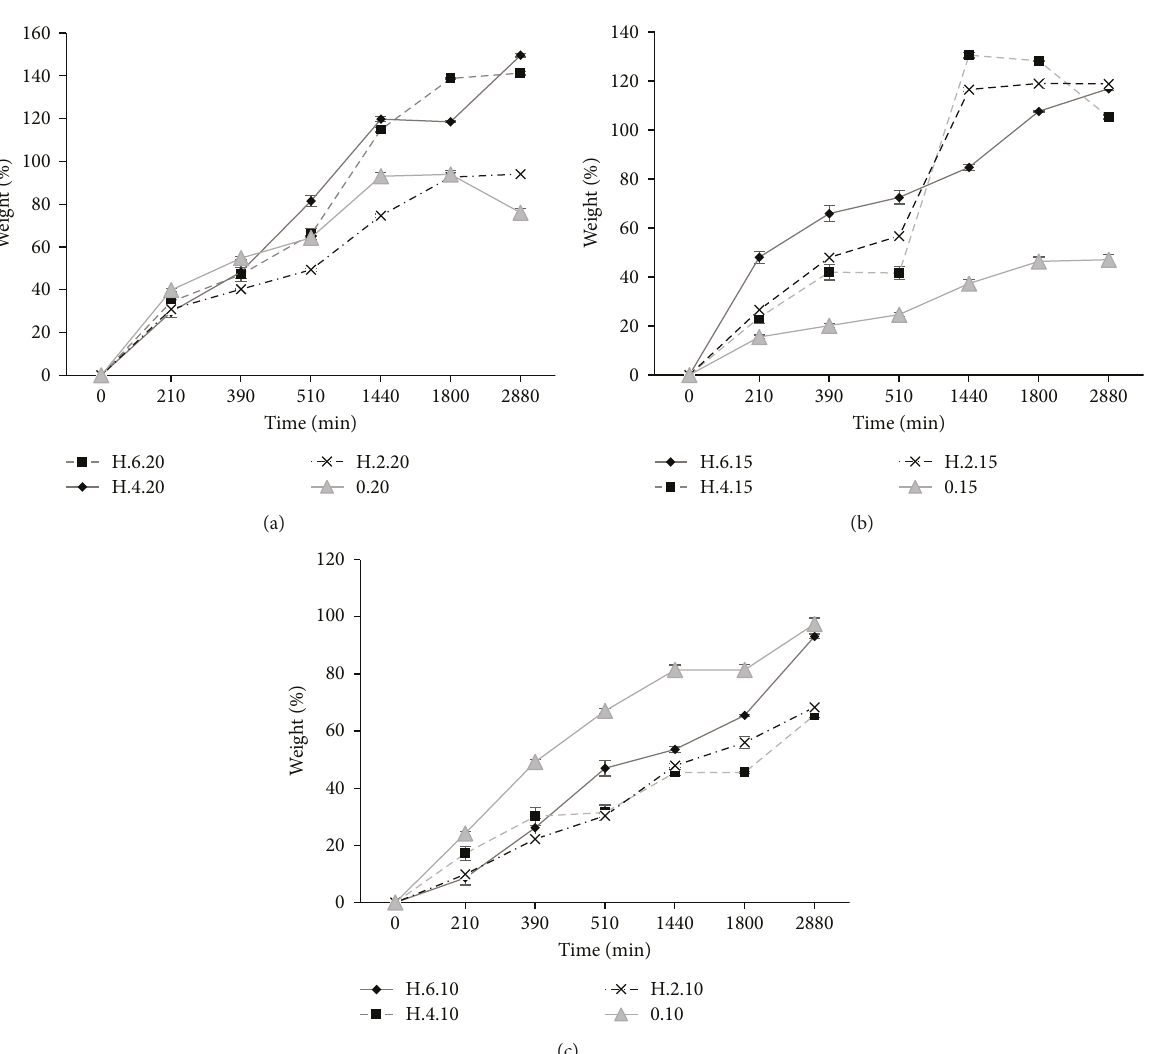
Figure 1: Swelling kinetics for di ff erent formulations of hydrogels incubated in PBS. All samples were prepared with HOP fi gures which are variations in gelatin concentration: (a) OP hydrogels with 20% gelatin, (b) OP hydrogels with 15% gelatin, and (c) OP hydrogels with 10% gelatin. The fi rst number in the legend indicates the HOP composition, and the second number corresponds to the gelatin concentration, i.e., H4.10 is the hydrogel with 4% HOP and 10% gelatin.